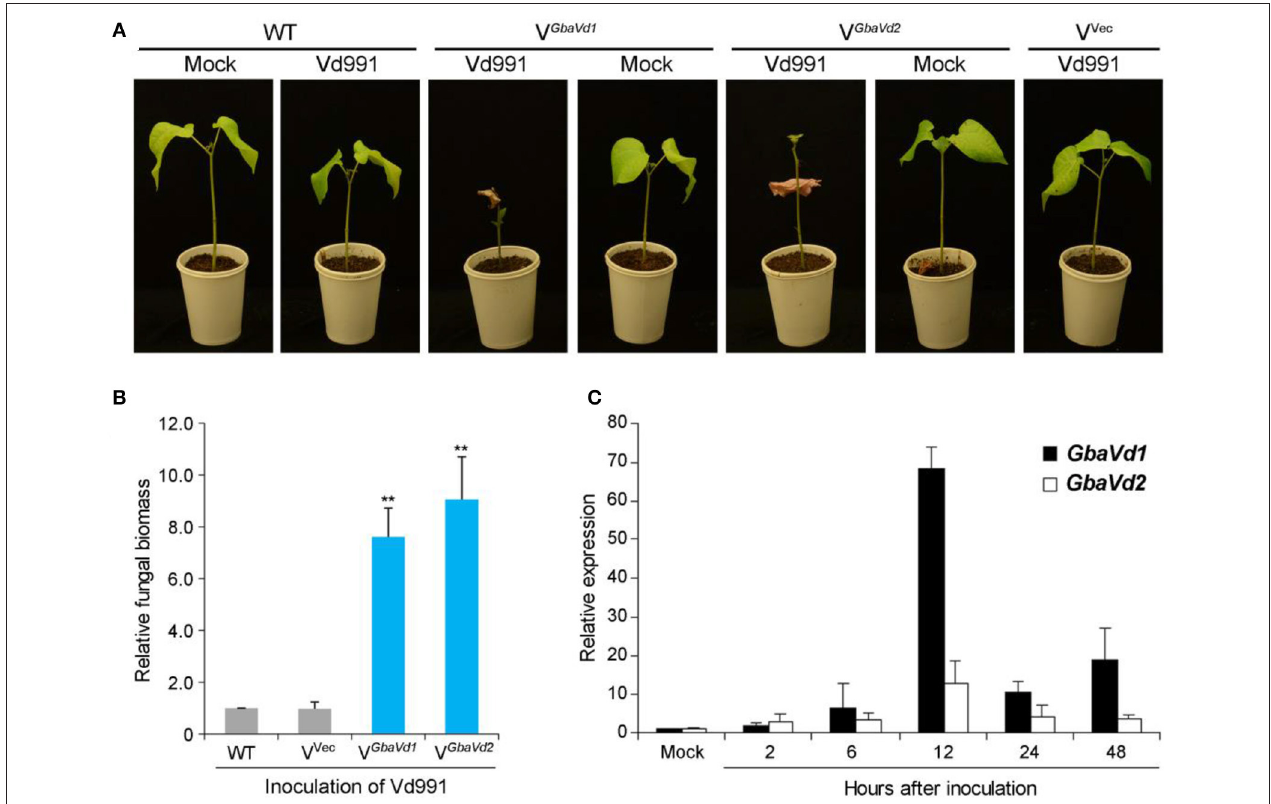
FIGURE 3 | The GbaVd1 and GbaVd2 genes play essential roles in Verticillium wilt resistance in cotton. (A) Determination of Verticillium wilt resistance in GbaVd1 - or GbaVd2 -silenced cotton plants. Approximately 14 days after the VIGS procedure in the resistant cotton G. barbadense cv. Hai7124, the GbaVd1 - or GbaVd2 -silenced plants were inoculated with 5 mL of conidial suspension (2 × 10 7 conidia/mL) from V. dahliae strain Vd991. The Verticillium wilt phenotypes were determined and photographed 3 weeks after inoculation. WT, the wild type of G. barbadense cv. Hai7124; Mock, inoculation with sterile water; V GbaVd1 /V GbaVd2 , the GbaVd1 - or GbaVd2 -silenced plants, respectively; V vec , VIGS positive control of infiltration with the empty vector pTRV2. (B) Real-time PCR quantification of fungal biomass in GbaVd1 - or GbaVd2 -silenced plants. Error bars represent standard errors, **significant differences ( P ≤ 0.01), according to unpaired Student’s t -test. (C) Expression patterns of GbaVd1 or GbaVd2 in cotton after inoculation with V. dahliae . Relative gene quantifications over time were calculated using the comparative threshold (2 − 11 CT ) method, and three independent biological replicates were analyzed. Error bars represent standard errors.